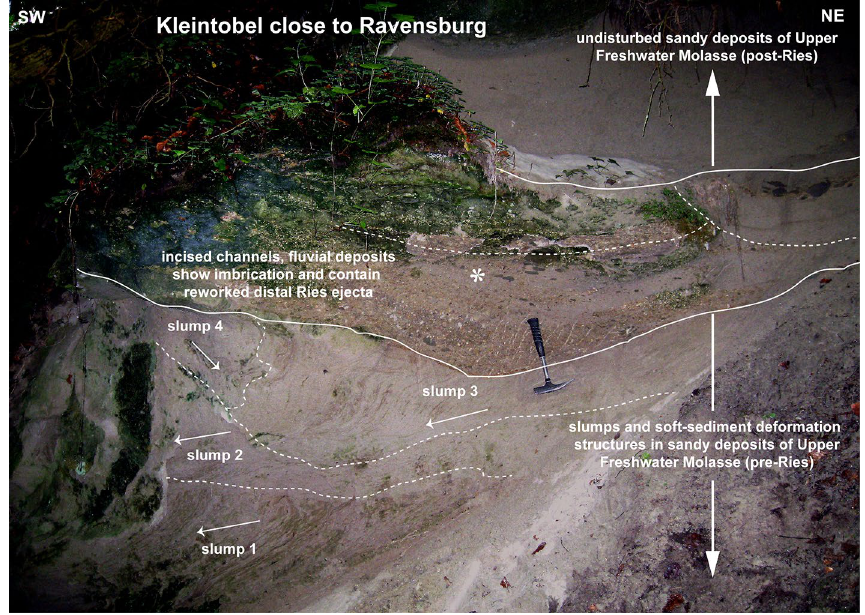
Figure 3. Bedding conditions in the Kleintobel close to Ravensburg, approximately 130 km SSW of the Ries crater rim. Channel-fills with reworked distal Ries ejecta are incised into slumped deposits of Upper Freshwater Molasse with soft-sediment deformation structures of pre-Ries age and show distinct imbrication (asterisk). Arrows show flow direction of slumps which generally tend towards the SW. Reworked distal Ries ejecta is overlain by undisturbed post-Ries deposits. Photograph taken in Kleintobel south of Biberach by